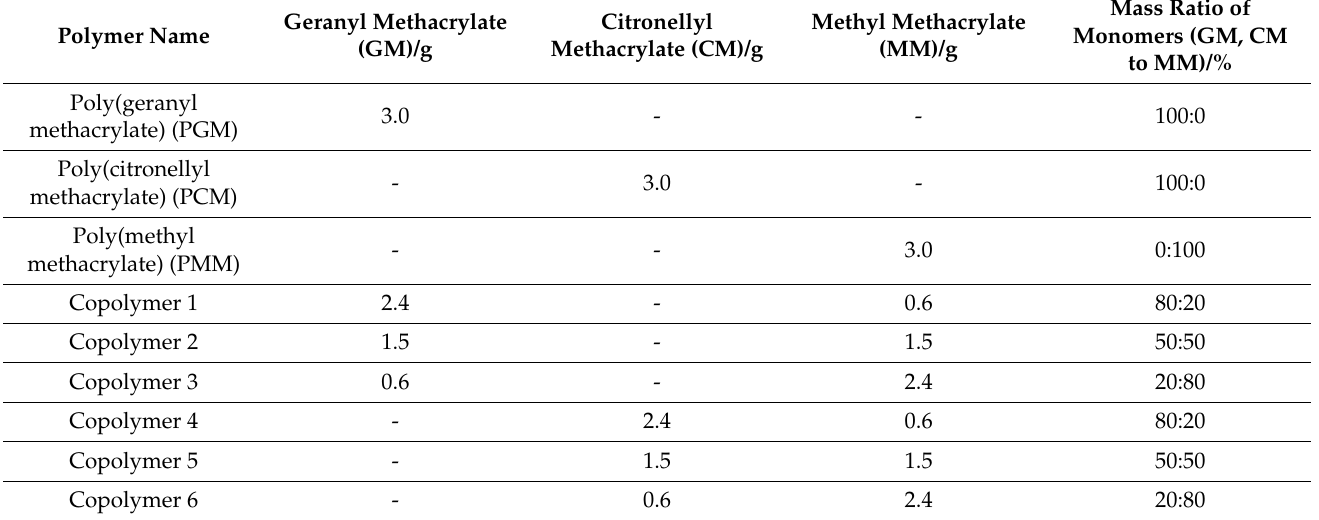
Table 1. Composition of monomer